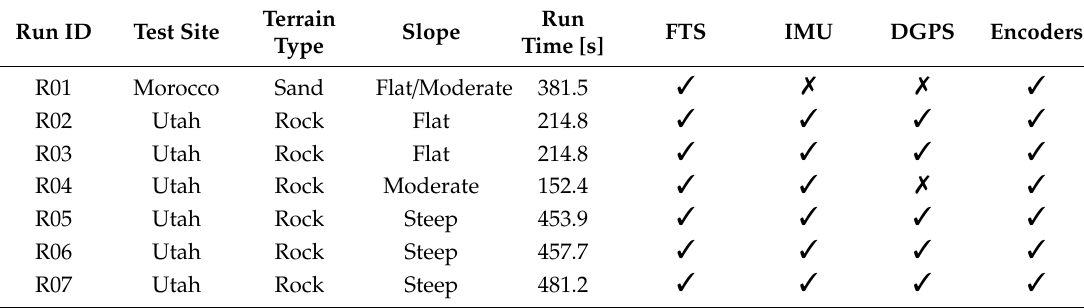
Table 1. Datasets gathered by SherpaTT during field trials; for each test run, terrain description, testing time and available logged sensors are indicated.